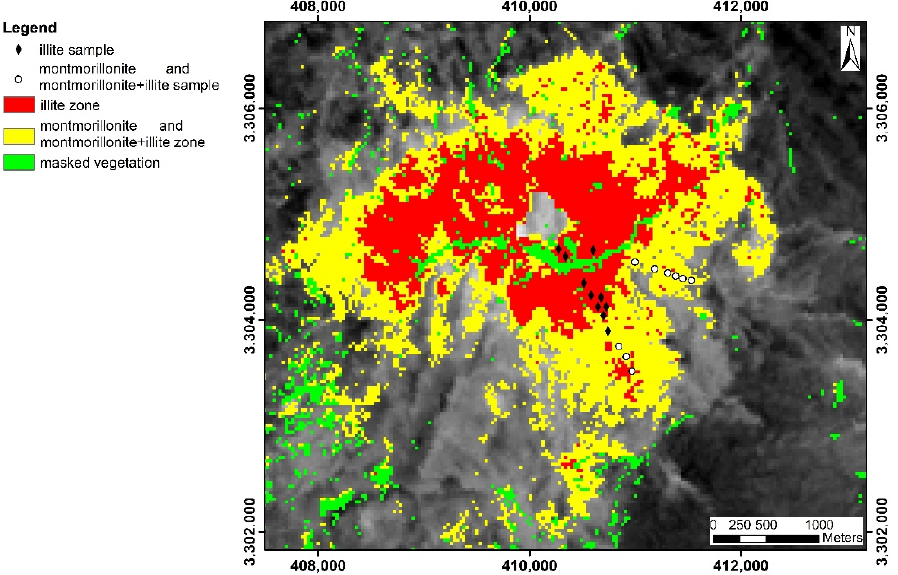
Figure 4. ASTER derived mineral map of the Kuh Panj area. The red class shows the relatively high crystallinity illite zone, and the yellow class shows montmorillonite and montmorillonite+il- lite with low crystallinity illite. Solid white circles show montmorillonite, and montmorillonite+illite samples and solid black diamonds show illite samples based on the SPECIM classification.